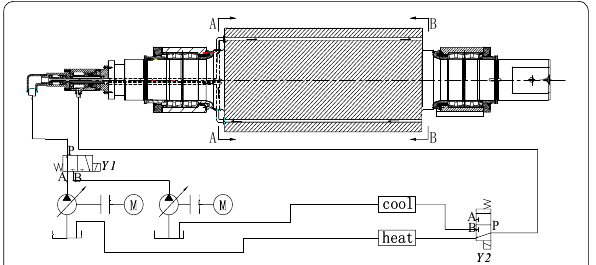
Figure 2 Thermal fluid heating work roll